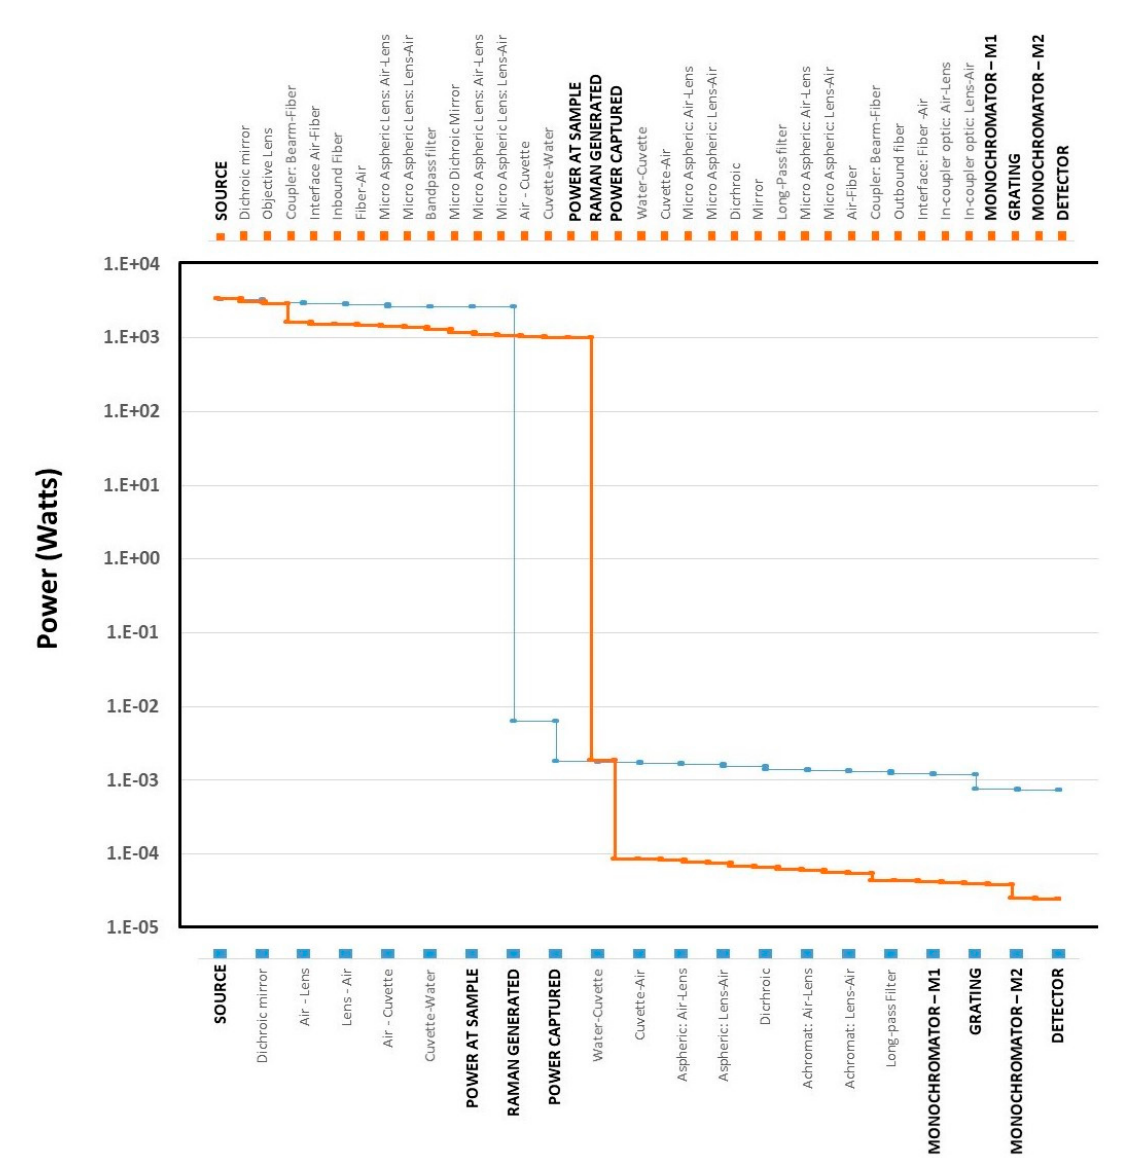
Figure 9. Power loss across open-path ( bottom ) and closed-path ( top ) systems.